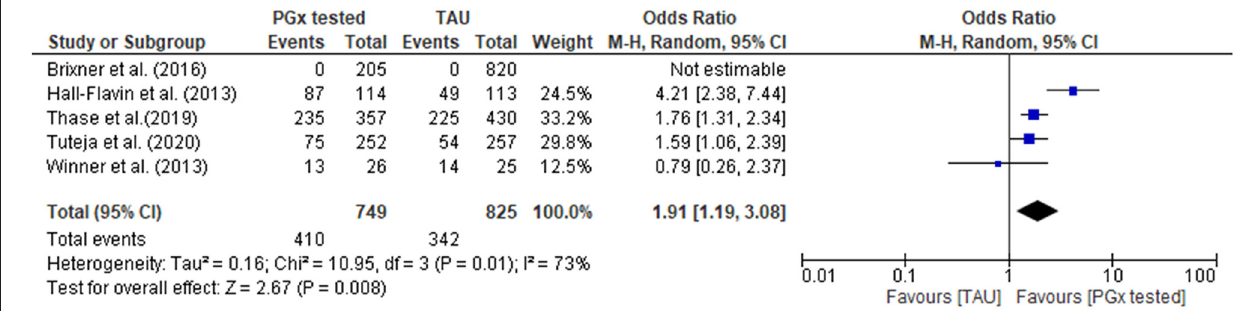
FIGURE 4 | Forest plot showing the effect of PGx testing on medication changes compared to treatment-as-usual (TAU). The number of “events” are the number of participants that received a medication change out of the total number of participants. Brixner et al. (2016) did not report the number of participants that received medication changes in both the PGx tested and the TAU arm, was not included in the